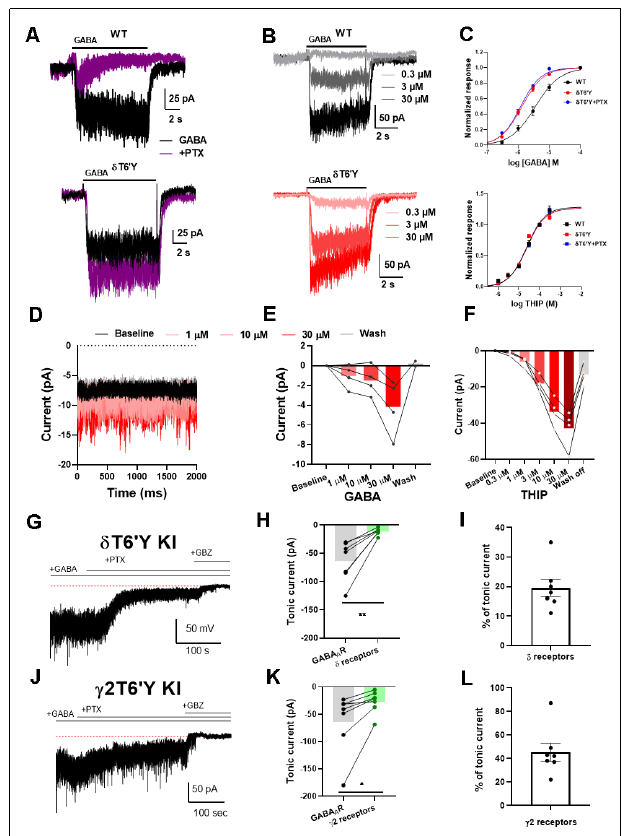
FIGURE 1 | Agonist sensitivity in recombinant α 4 β 2 δ GABA A Rs expressed in N2a cells and KI mice. (A) Example traces of response to 1 µ M GABA elicited from N2a cells transfected with wildtype (WT) GABA A R subunits. This response was abolished by co-application of 100 µ M PTX. The δ T6’Y mutation exhibited PTX-insensitivity when expressed with α 4 and β 2 subunits. (B) Representative traces of different GABA concentrations (0.3–30 µ M) from WT GABA A Rs and δ T6’Y mutation expressed in N2a cells. Shading indicates different GABA concentrations. (C) Concentration response curves for agonists GABA and THIP, respectively. For GABA, fits to the Hill equation yielded EC 50 values of 3.61 µ M, 1.33 µ M, and 1.21 µ M for WT and δ